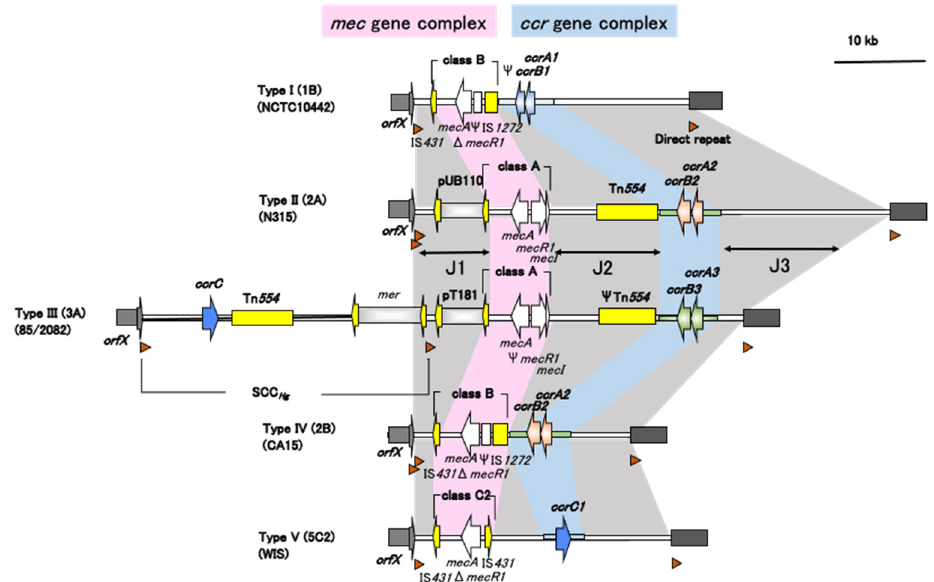
Figure 2. Comparison of the structures of SCC mec I–V in S. aureus . SCC mec should contain the mec gene complex and ccr gene (complex), with integration site sequence and direct repeats at both ends. Adapted with permission from Ref. [17]. 2009, American Society for Microbiology.